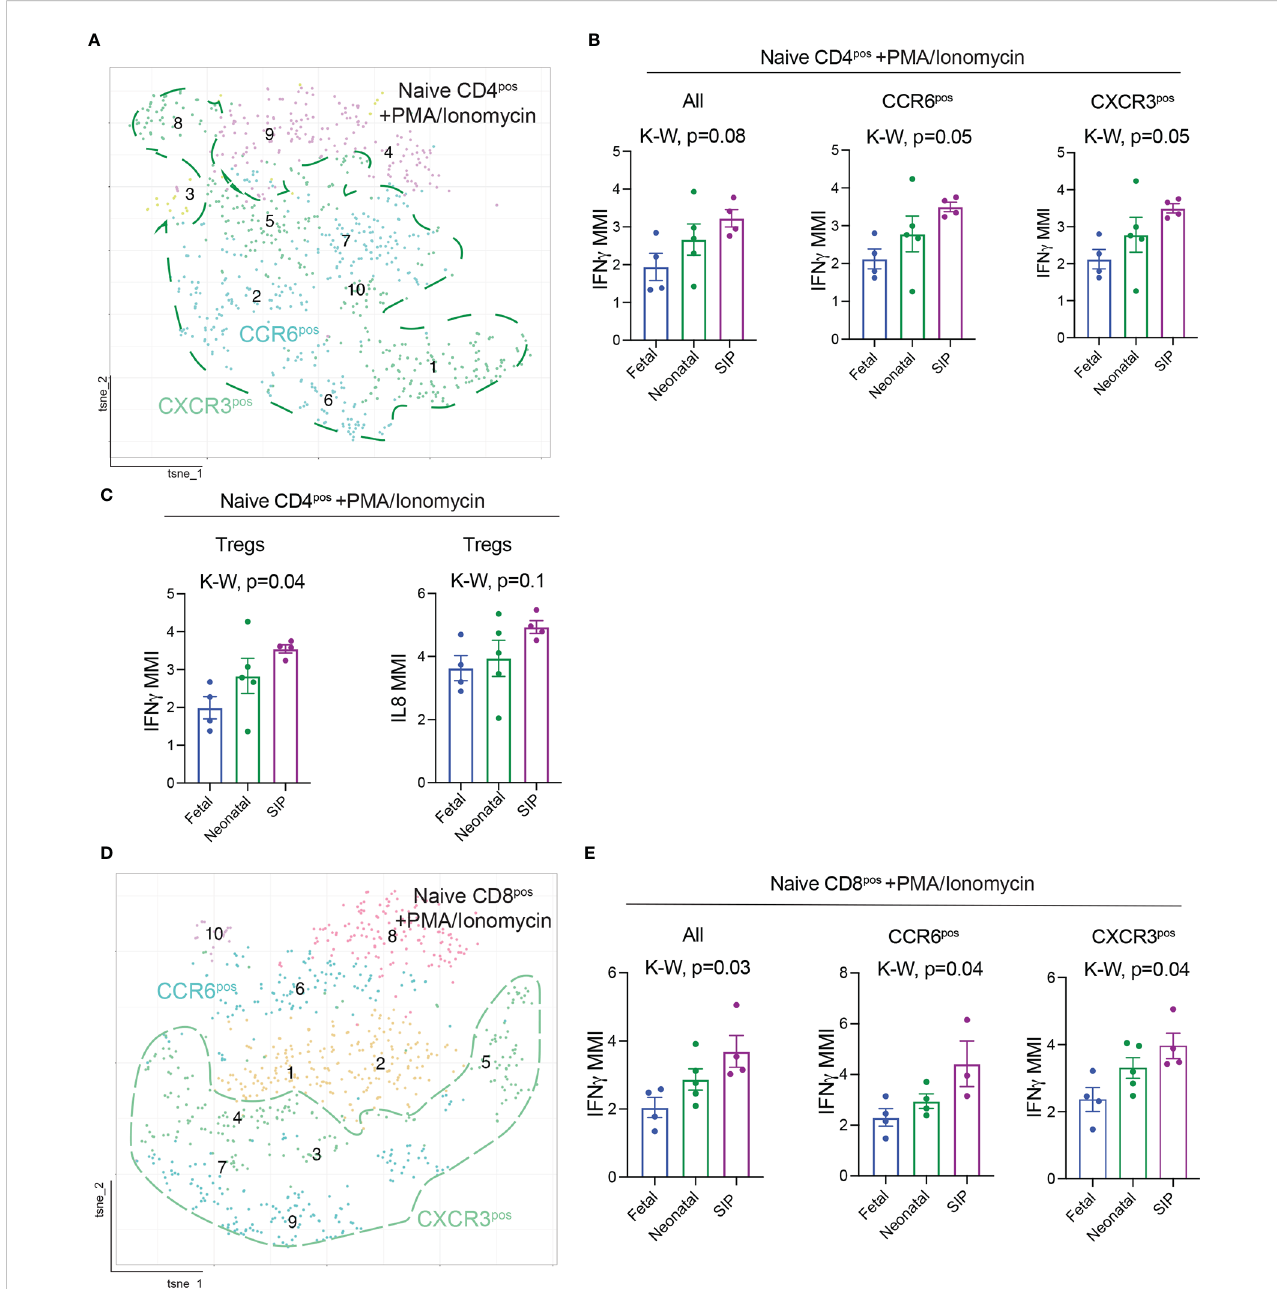
FIGURE 4 Interferon gamma (IFN g ) expression is increased in T cells in SIP. (A) t-SNE of naïve (CD45RA + CCR7 + ) CD4 + T cells after stimulation with PMA/Ionomycin exported from Premium Cytobank ® . (B) MMI expression of IFN g on all, CCR6 + , CXCR3 + , FOXP3 + naïve CD4 + T cells after stimulation. (C) MMI of IL8 on naïve T regs. (D) t-SNE of naïve (CD45RA + CCR7 + ) CD8 + T cells after stimulation. (E) MMI expression of IFN g on all, CCR6 + , CXCR3 + , naïve CD8 + T cells after stimulation. (B, C, E) : Each dot represents the median expression of CCR6 on that population of cells in each case (methods, fetal n=4, neonatal n=5, SIP 4). MMI – mean metal intensity, p-value, K-W Kruskal-Wallis test